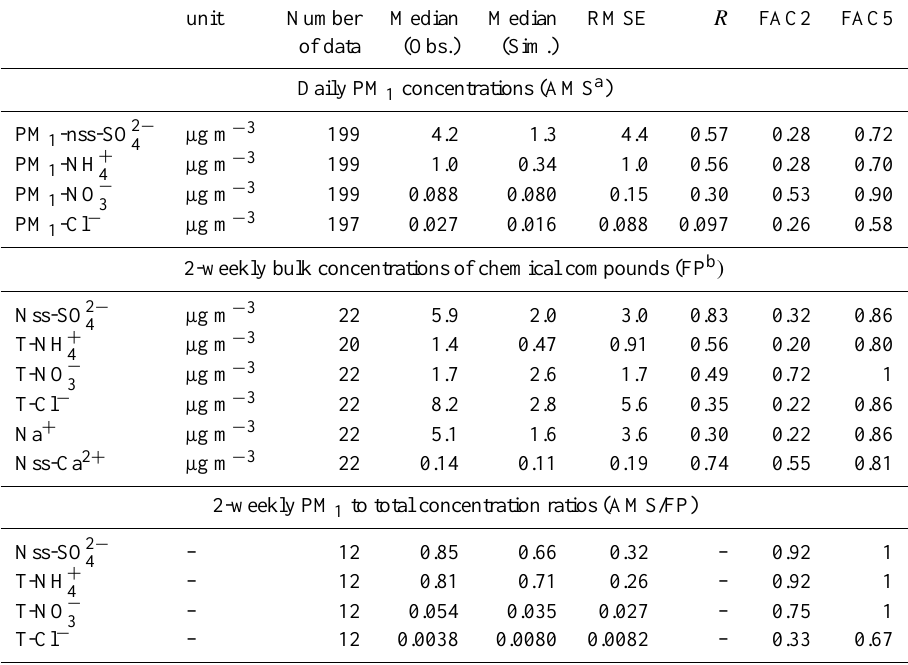
Table 6. Statistical analysis for comparing between observation and simulation at the Hedo EANET and CHAAMS stations. unit Number Median Median of data